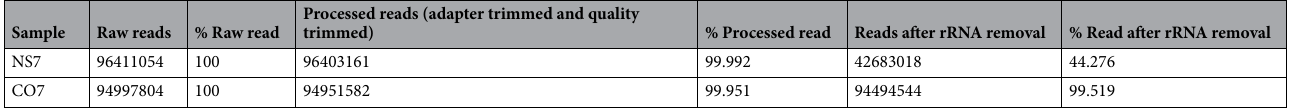
Table 2. Summary of paired-end RNA sequences of preserved mulberry leaves.